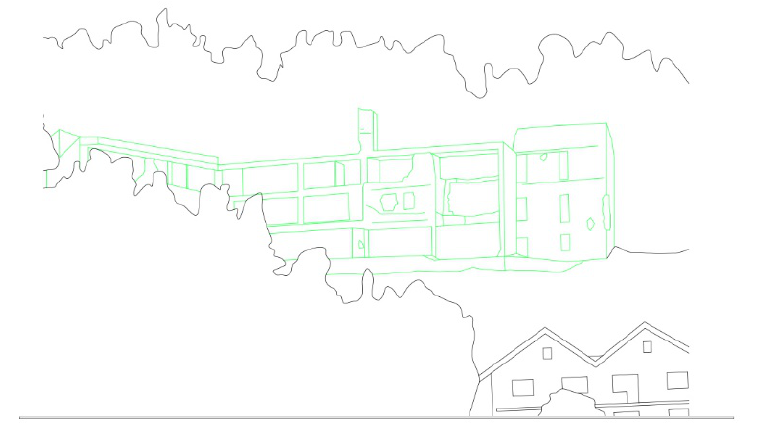
Figure 14: War-damaged building in Šumarska ulica, above Širokača, on Republika Srpska side of the